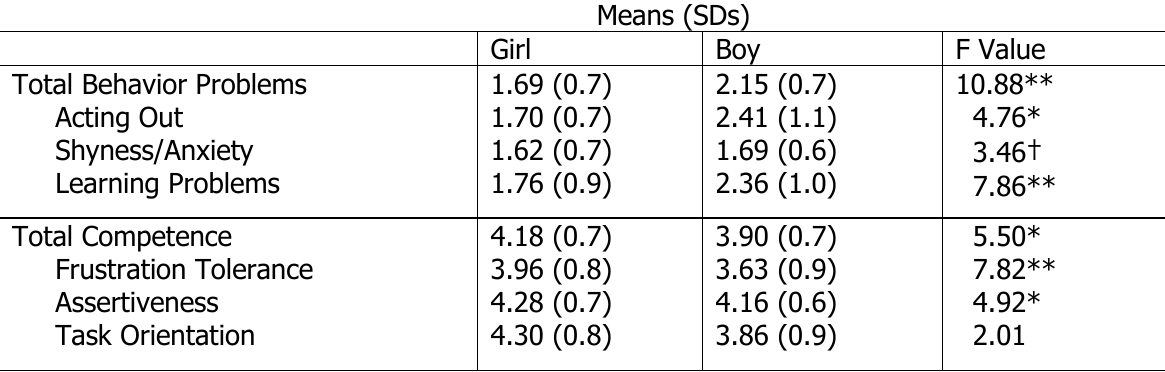
Teacher Ratings of Child Competence and Behavior Problems by Gender